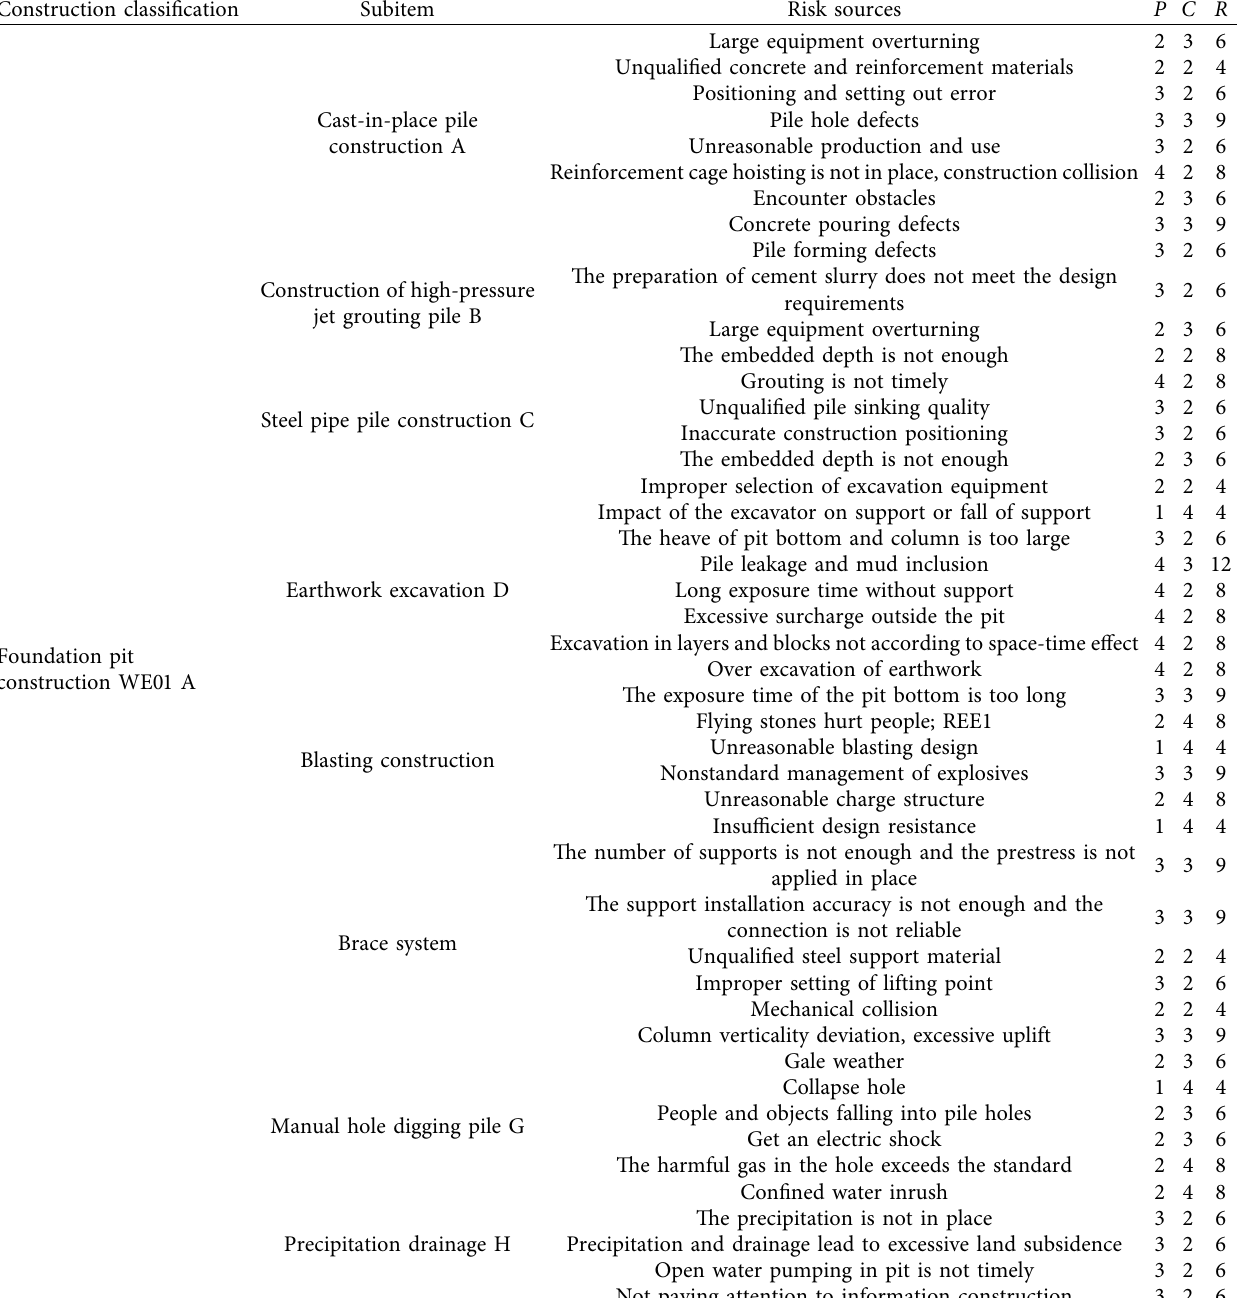
Table 16: List of construction risk